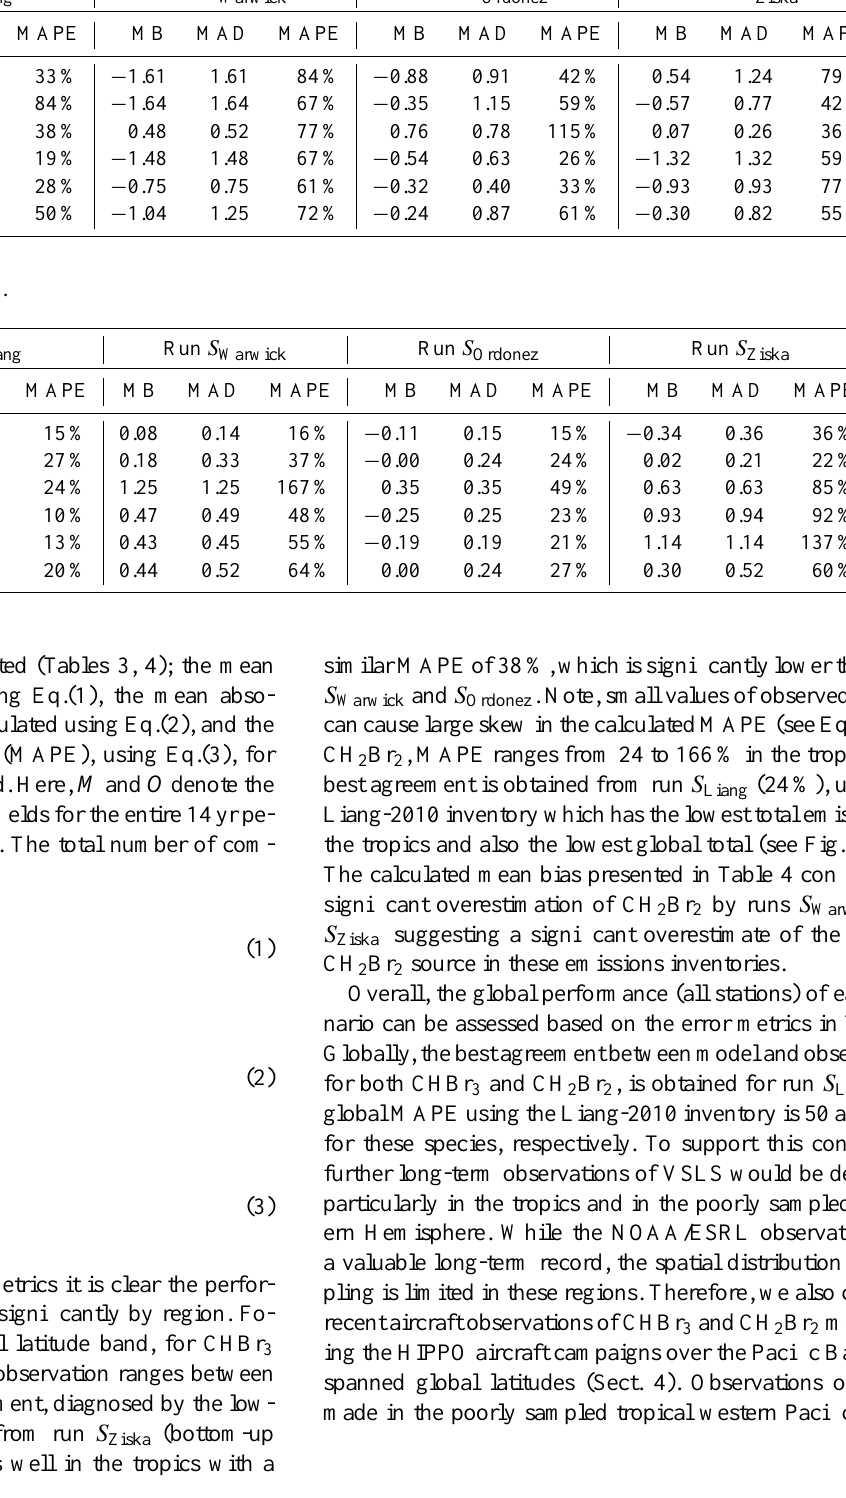
Table 3. Summary of calculated error metrics between NOAA/ESRL observed surface CHBr 3 with analogous fields from CTM runs S Liang , S Ziska , S Warwick and S Ordonez . Shown is the mean bias (MB) and the mean absolute deviation (MAD) both in units ofppt. Also shown is the mean absolute percentage error (MAPE, see text). These fields were calculated for the entire 14yr period of available observation (1 January 1998–1 January 2012) and for the 5 latitudinal bands shown in Fig. 4. The global values shown are a comparison for all 14 stations. Latitude